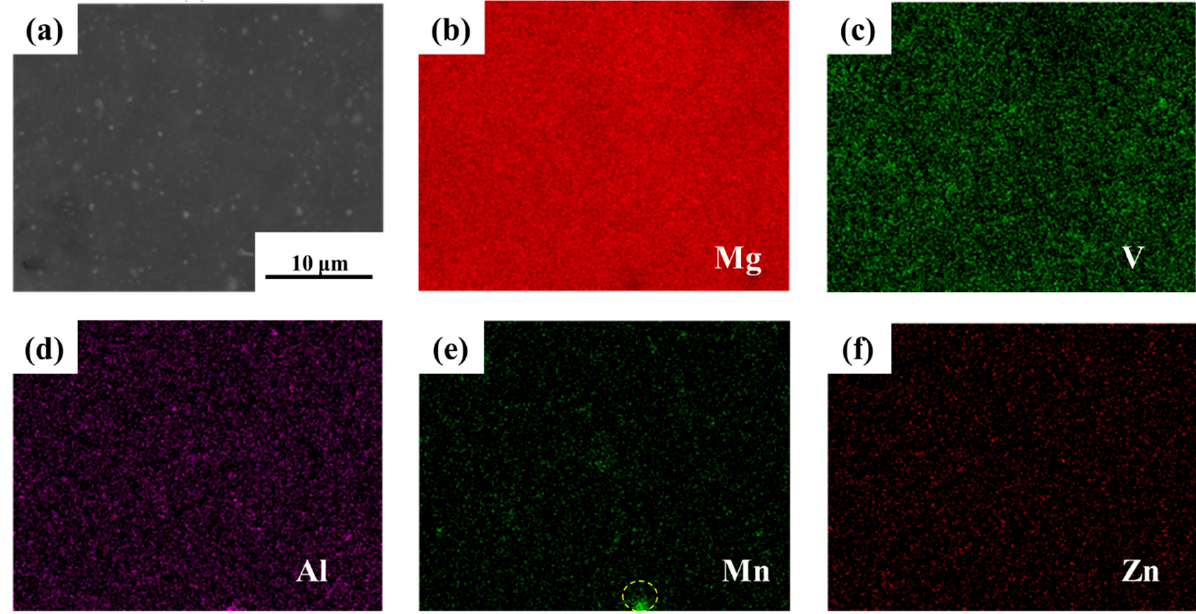
Figure 11. The SEM image ( a ) and corresponding EDS maps of Mg ( b ), V ( c ), Al ( d ), Mn ( e ) and Zn ( f ) for the AZ31-5 wt % V P powders.